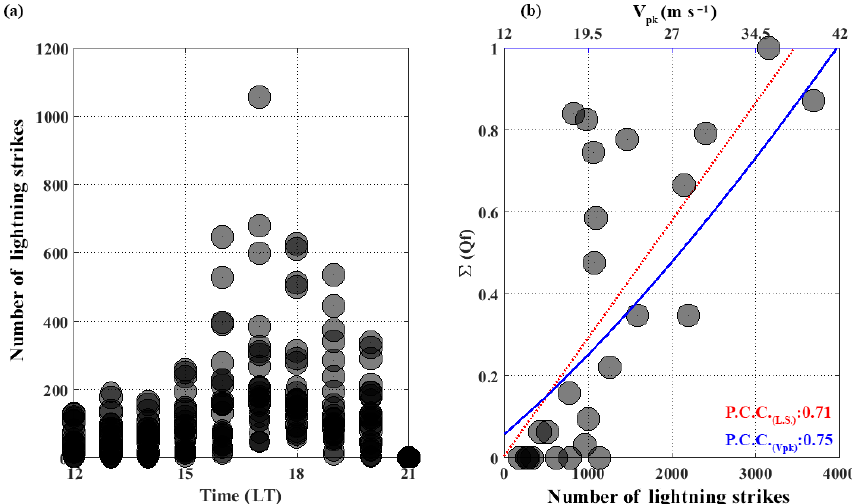
Figure 10. Temporal distribution of lightning strikes (a) . Distribution of normalized (cid:54) ( Q f ) as a function of lightning strike activity and the prereversal drift peak V pk (b)